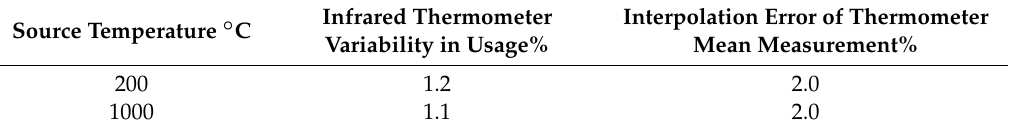
Table 2. Contributions of measurement uncertainties to overall measurement uncertainty.